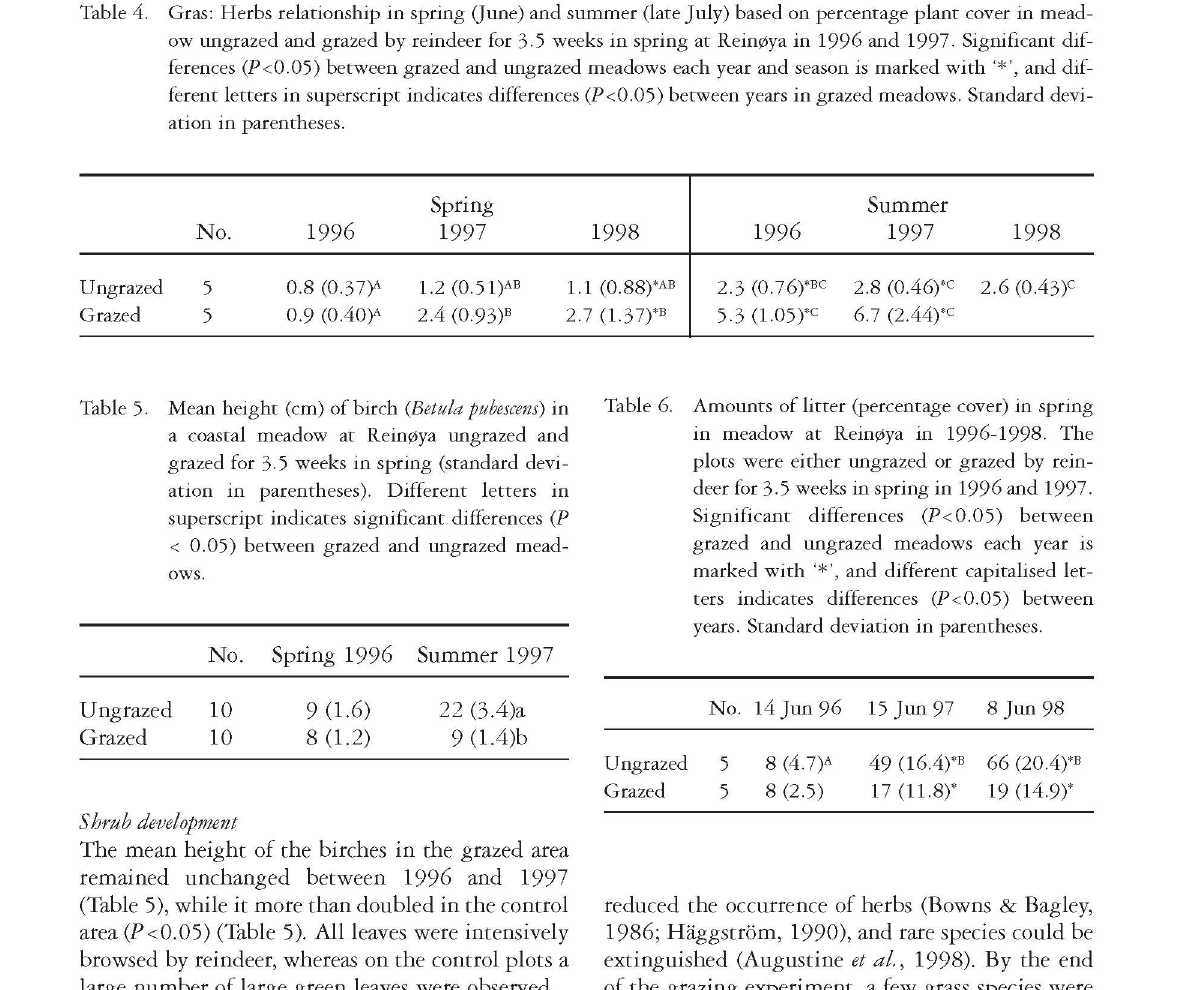
Table 4. Gras: Herbs relationship in spring (June) and summer (late July) based on percentage plant cover in mead¬ ow ungrazed and grazed by reindeer for 3.5 weeks in spring at Reinøya in 1996 and 1997. Significant dif¬ ferences (P <0.05) between grazed and ungrazed meadows each year and season is marked with '*', and dif¬ ferent letters in superscript indicates differences (P <0.05) between years in grazed meadows. Standard devi¬ ation in parentheses.